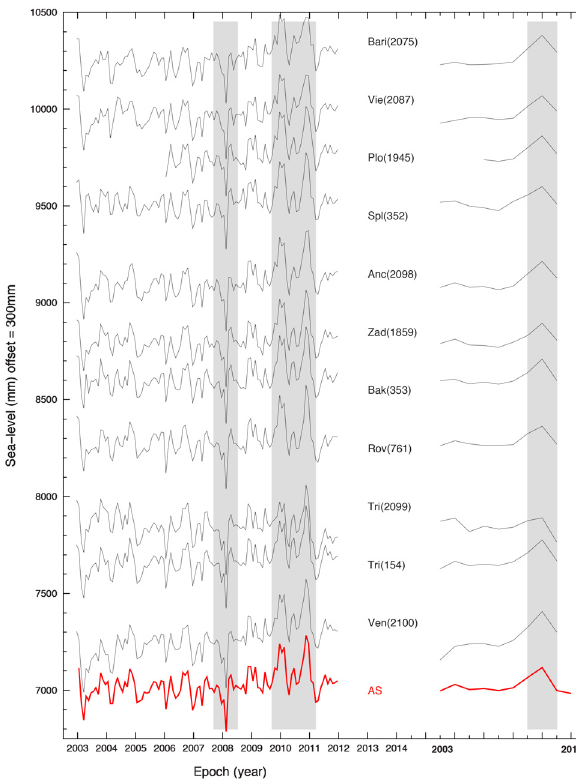
Figure 4. Adriatic time series (monthly on the left and annual on the right), and their stack (red) for the decade 2003-2012. The shaded rectangles mark the occurrence of the sea-level anomalies discussed in the